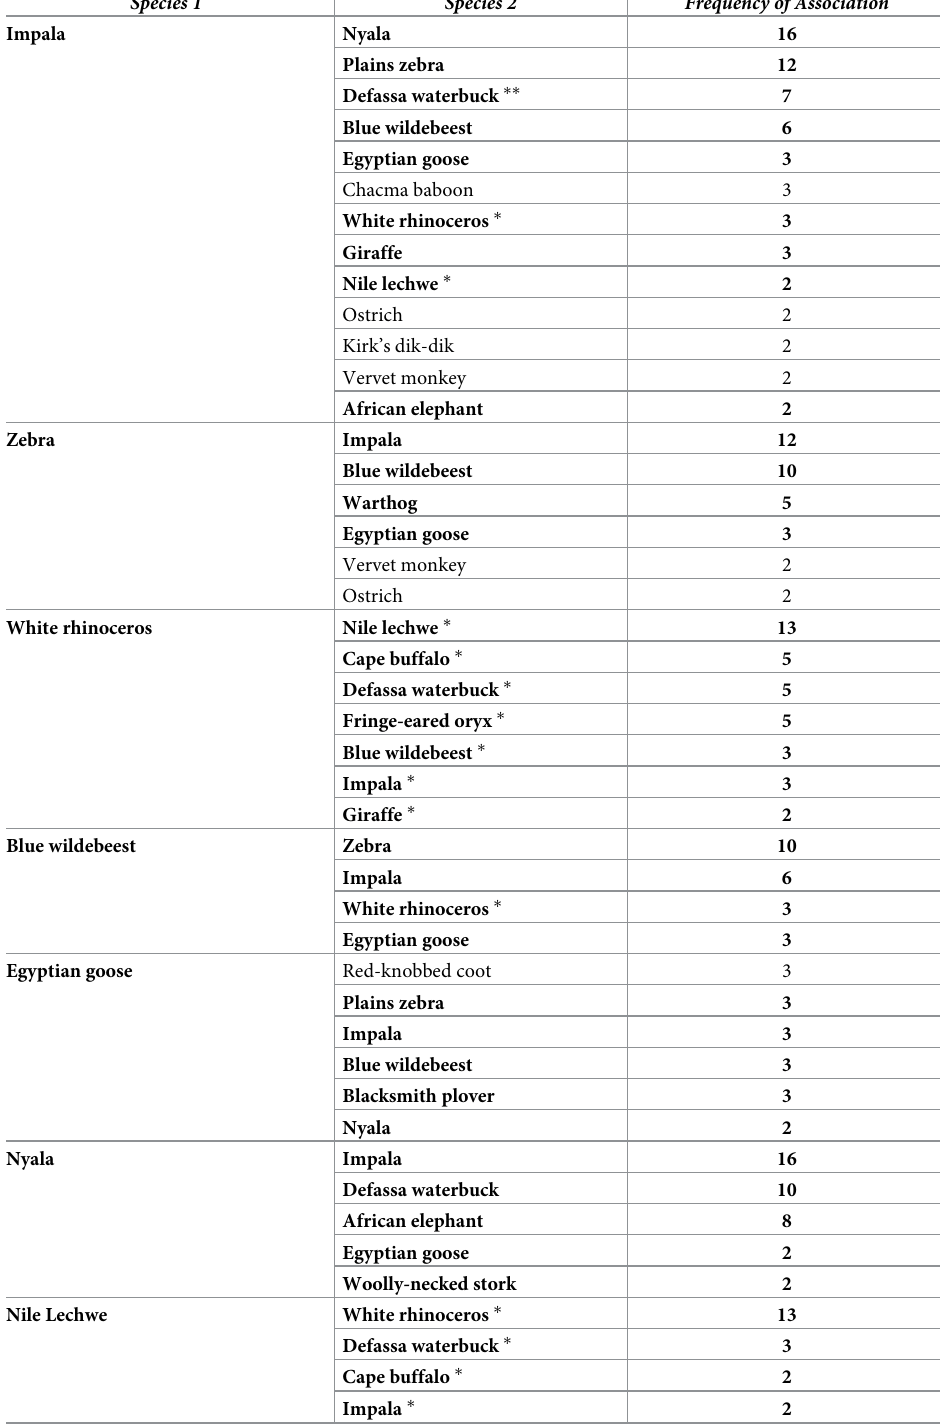
Table 4. Number of associations between two species, i.e., the number of times these two species were observed within the same ’group’ (within 6 body lengths of each other) during one of their focal